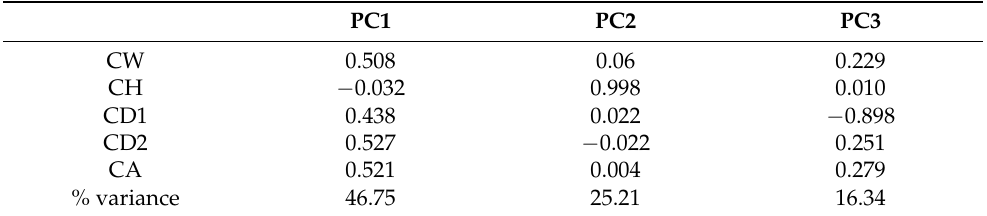
Table 4. Correlation coefficients of single descriptors with the three main principal components (PCs).